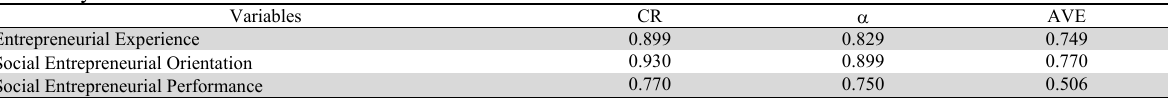
Reliability Test